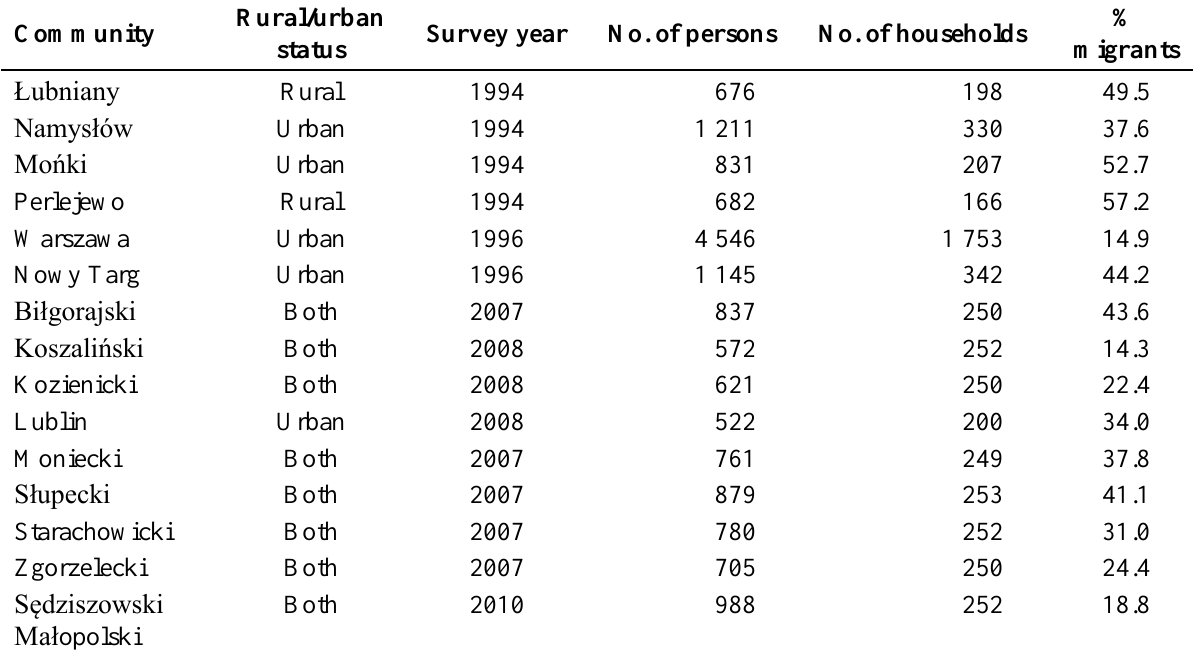
Table 2. Basic information on the ethnosurveys completed in Poland